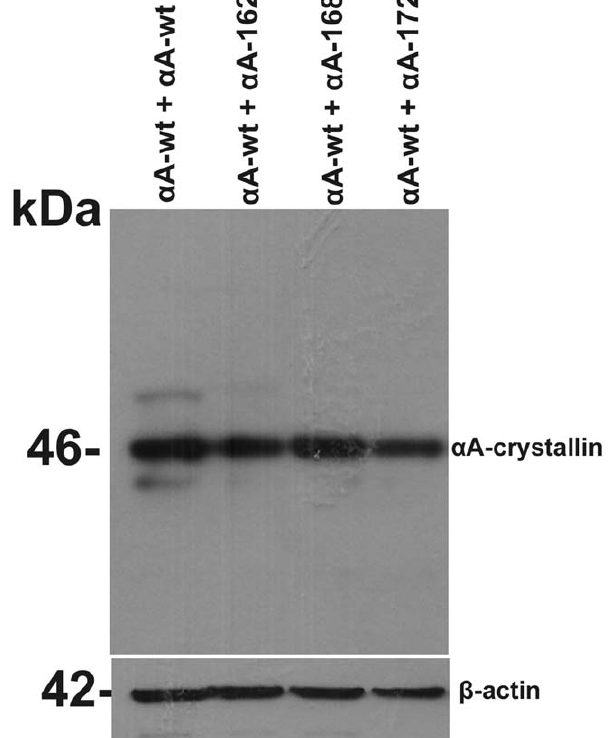
Figure 4. Level of expression of the various a A-crystallins in HeLa cells when they were co-expressed with a Awt.